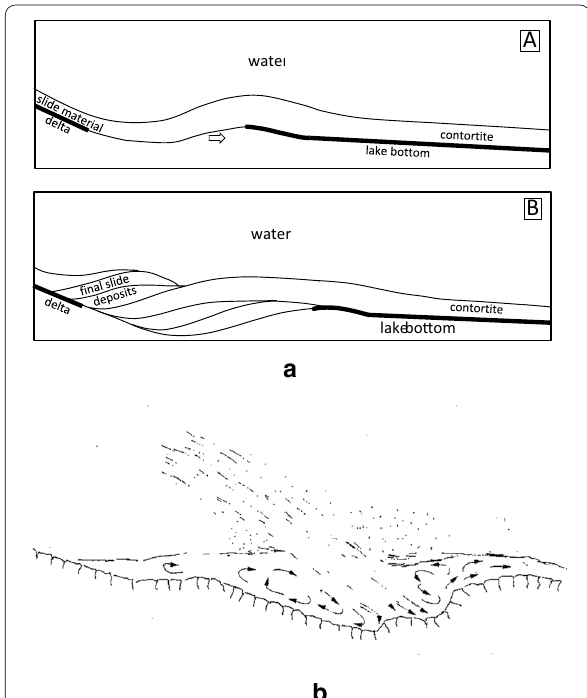
Fig. 4 a The suggested scenario of the mass flow dynamics, an expanded version of Schnellmann (2004). The overall horizontal length is around 200 m. A: The material of the slide is considered as a liquid, scouring semi-pelagic sediments at the impact zone and continues to flow on the lake–bottom, producing contortites or gets partly homogenized as 1996 in Lake Brienz. A small part of the mass is ejected into suspension. The horizontal pressure causes the seabed to bulge. B: In the final phase, the eroded depression is filled or partly filled. b “Scour hole in plunge pool due to dynamic impact of trajectory jet” (from Hager, 1995, p. 143). The shown energy dissipater illustrates the forces of an internal hydraulic jump of a slide, which disintegrates its own structure and also the structure of the precedingly deposited slide material. A mudclast–conglomerate (debrite) results and large parts of the material are injected into